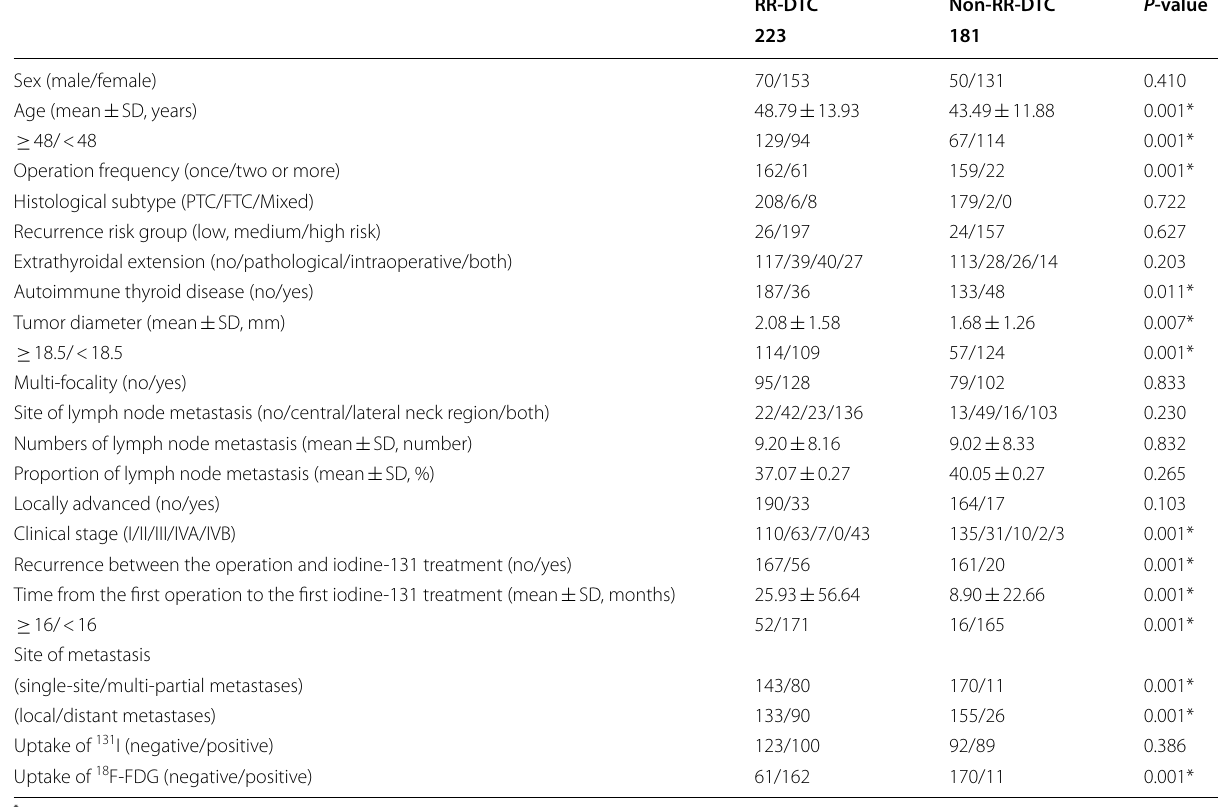
Table 1 Patient demographics, tumor histology, and laboratory